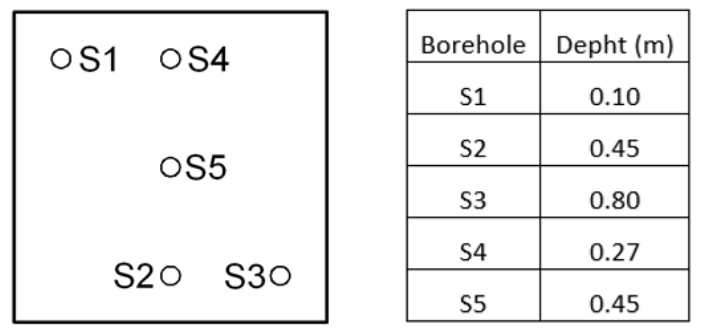
Figure 1. Position and depth of the boreholes drilled in the sample.